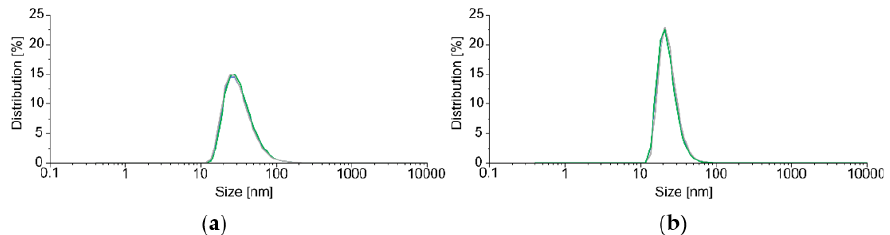
Figure 2. Size (diameter) distribution of Fe 3 O 4 NPs redispersed in chloroform (20 ◦ C) ( a ) by volume ( b ) by number. Measurements were conducted in three repetitions (visible as green, blue, and gray lines). The average sizes for the average measurement were 34.32 nm with a standard deviation of 17.79 nm by volume and 23.49 nm with a standard deviation of 7.66 nm by number. To procees full characterization of Fe 3 O 4 NPs we analized Powder X-ray diffraction (Figure 3) as well as make the picture on Scanning Transmission Electron Microscopy (STEM) (Nova NanoSEM 450, Lincoln, NE, USA).